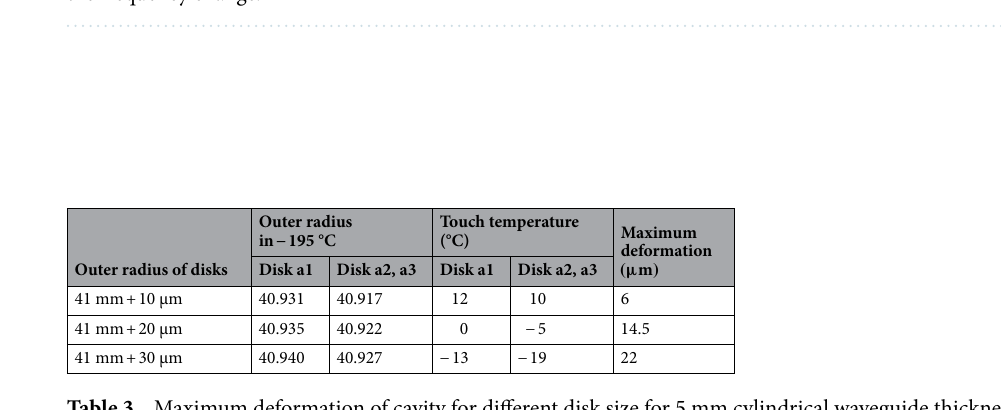
Table 3. Maximum deformation of cavity for different disk size for 5 mm cylindrical waveguide thickness.